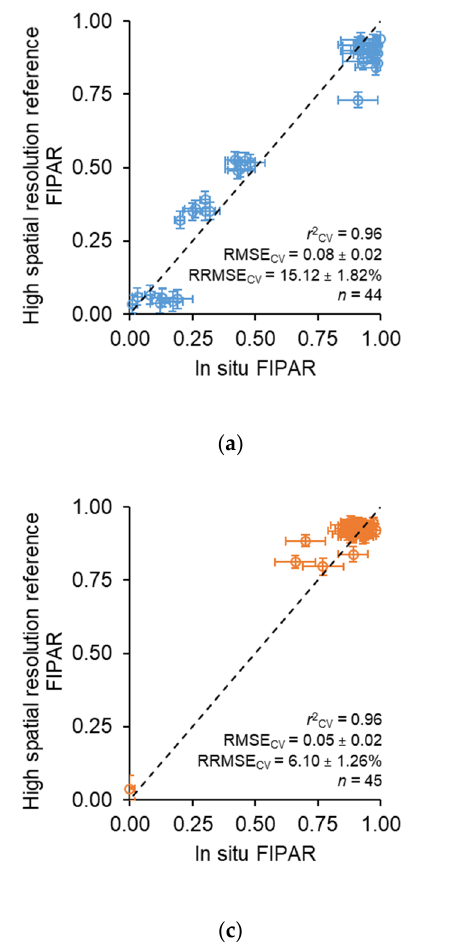
Figure 10. Comparison between high-spatial-resolution reference maps and in situ reference measurements of FIPAR ( left ) and CCC ( right ) for the Las Tiesas–Barrax ( a , b ) and Wytham Woods ( c , d ) campaigns. The dashed line represents a 1:1 relationship, whilst error bars represent expanded uncertainties at the k = 2 coverage interval.